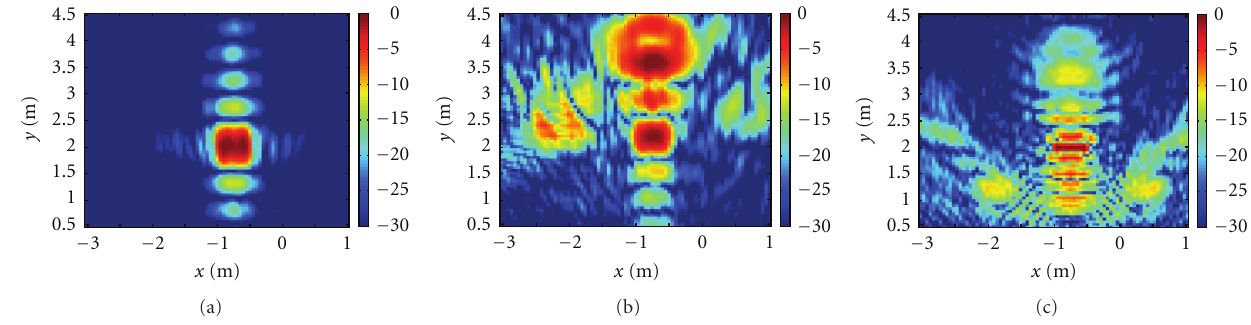
Figure 6: Back-projection images of a metallic plate extending from x = − 1 to − 0.5 at y = − 2 for the configuration in Figure 2 with data collected over the band 1.7–2.0 GHz: (a) image in free space, (b) image in presence of the cinderblock wall using the free space Green’s function, (c) image in presence of the cinderblock wall using the periodic layer Green’s function.